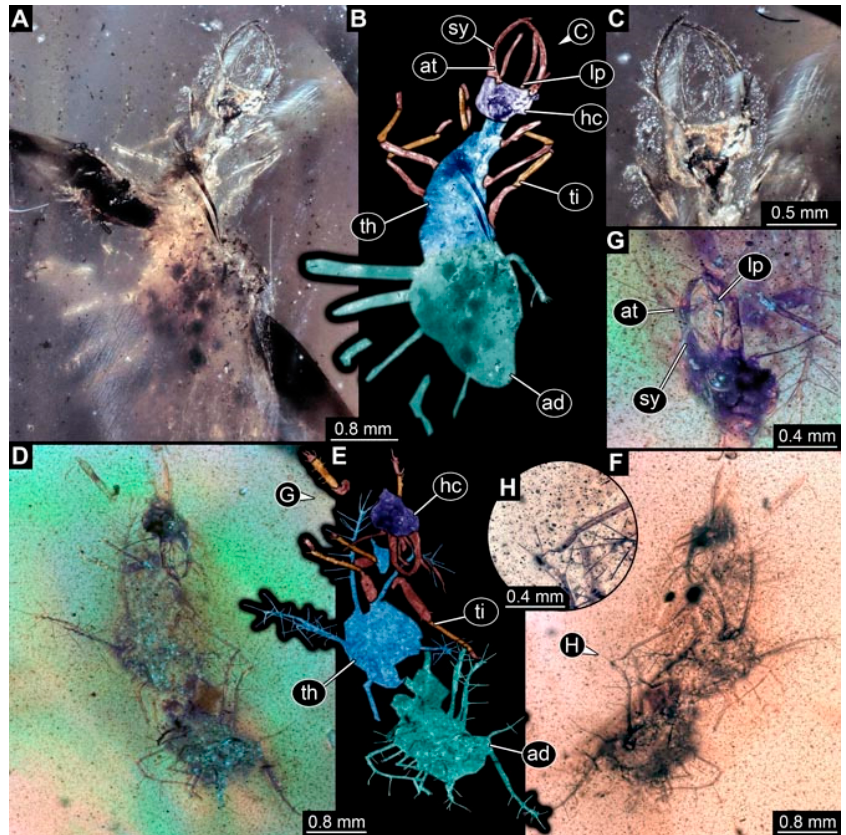
Figure 28. Two specimens in Myanmar amber. ( A – C ) Specimen 4850 (PED 0667). ( A ) Dorsal view. ( B ) Dorsal view, colour-marked. ( C ) Close-up of head capsule in dorsal view. ( D – H ) Specimen 4852 (PED 0715). ( D ) Ventral view. ( E ) Ventral view, colour-marked. ( F ) Dorsal view. ( G ) Close-up of head capsule in ventral view. ( H ) Close-up of distal end of trunk appendage. Abbreviations: ad = abdomen; at = antenna; hc = head capsule; lp = labial palp; sy = stylet; th = thorax; ti = tibia.